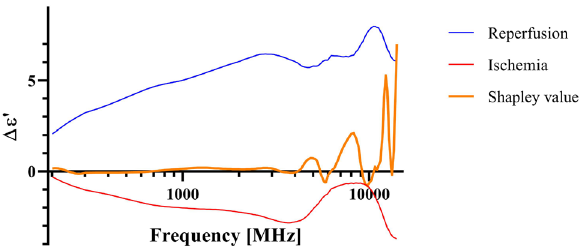
Figure 2. Shapley values plotted with the relative change in dielectric constant for ischemic and reperfusion phase. Where positive shapley values indicate positive contribution to the model classification performance and negative shapley values implies negative contribution to the model